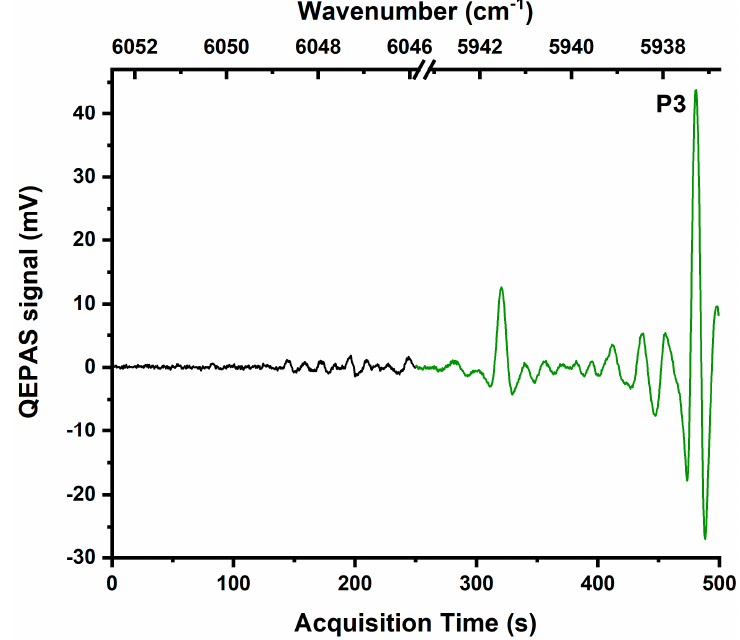
Figure 3. 2f-QEPAS signal for a mixture containing 1% ethane and 99% nitrogen. The black curve was obtained by sweeping the full dynamic range of LD1, and the green curve was obtained by sweeping the full dynamic range of LD2.